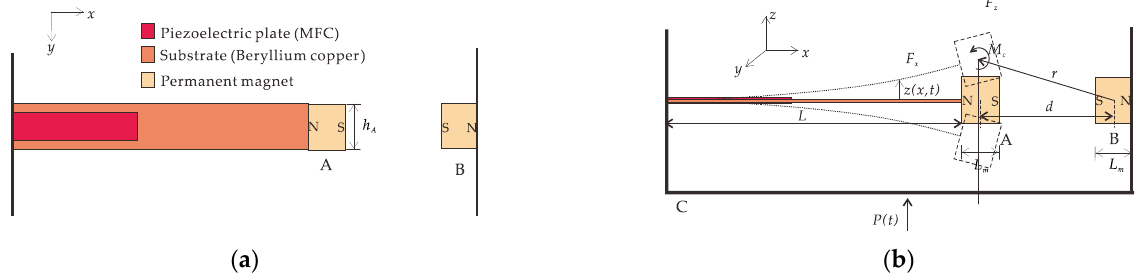
Figure 1. Nonlinear piezoelectric cantilever beam model: ( a ) front view; ( b ) vertical view. Table 1. Physical parameter values of the piezoelectric cantilever beam vibration system.